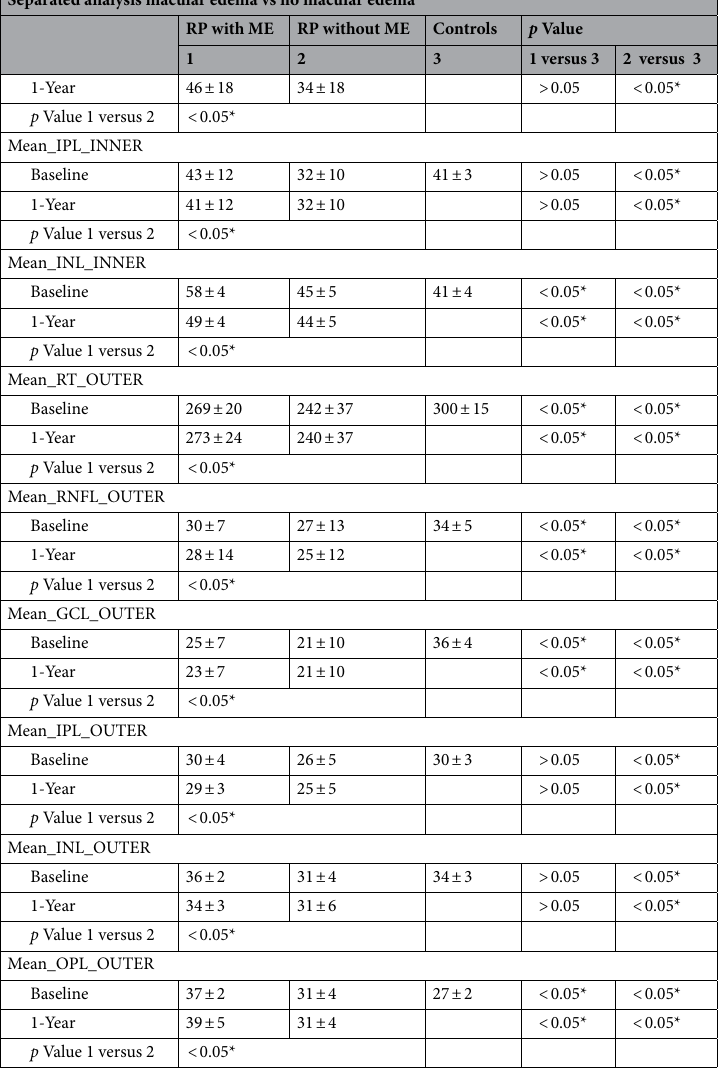
Table 3. Separate analysis of RP eyes affected by macular edema versus no macular edema. Only the statistically significant difference between RP eyes with and without macular edema are reported. The complete data are shown in Supplementary material. The following abbreviations are used: choroidal thickness (CT), Sattler layer thickness (SLT), Haller layer thickness (HLT), vessel density (VD), superficial capillary plexus (SCP), deep capillary plexus (DCP), retinal thickness (RT), retinal nerve fiber layer (RNFL), ganglion cell layer (GCL), inner plexiform layer (IPL), inner nuclear layer (INL), outer plexiform layer (OPL). Statistically significant values, expressed for simplicity as p < 0.05, are marked by asterisks